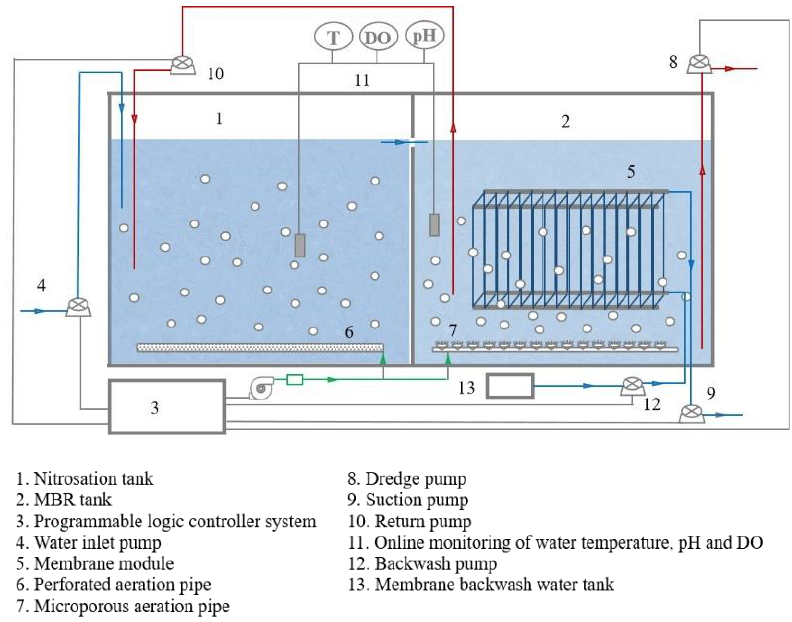
Figure 1. Schematic diagram of the pilot reactor device.